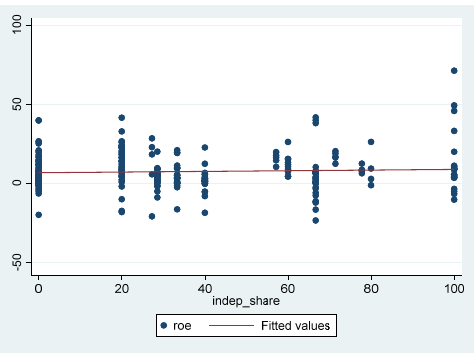
Figure 3. Scatter Plot between ROE and the Proportion of Independent Board Members.